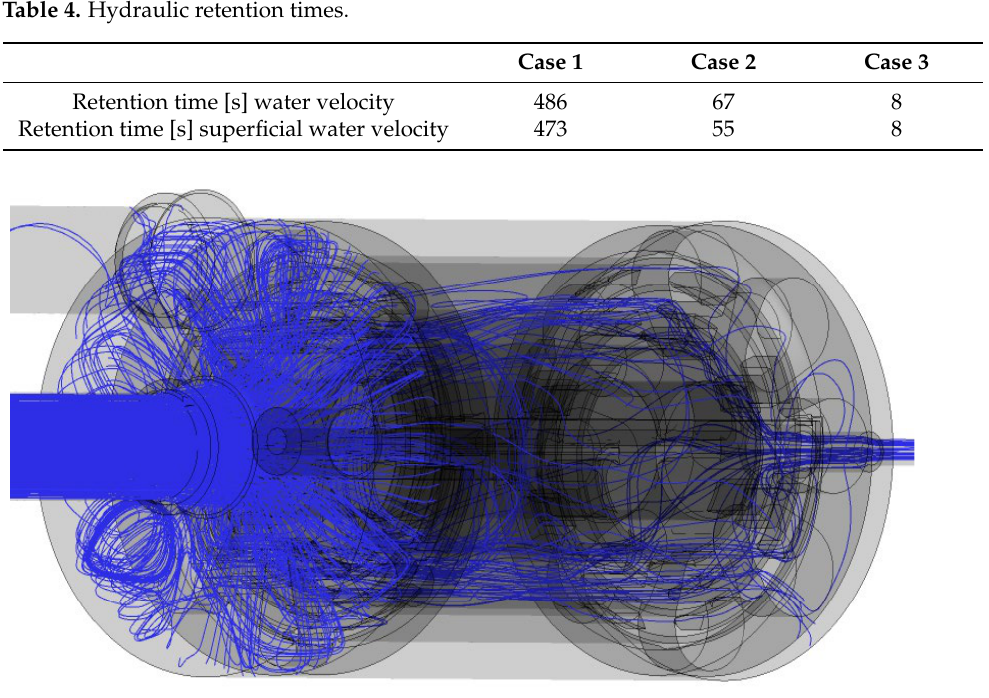
Figure 8. Vectors of water velocity: ( a ) Case 3 and ( b ) Case 2 while watering. 3.4. Gas Holdup The gas holdup is the most significant parameter in industrial bubble flows, and it influences the separation efficiency. The electrolysis commenced gas filling in the EC re- actor, and the hydrogen bubbles reached the peak within 3 s. The gas holdups at the be- ginning were 0%, and they showed to be filled up to 0.3% (Case 1), 3.76% (Case 2), and 0.22% (Case 3) at the end of the watering stage. The speculation for the most abundant gas holdup for the typical BC was the smallest ratio of water flow to gas flow. After 2 min of degassing, Case 4–6 reached approximately 0.02% of gas holdup. Figure 9 shows the gas volume fractions before degassing (i.e., after watering) and after degassing.